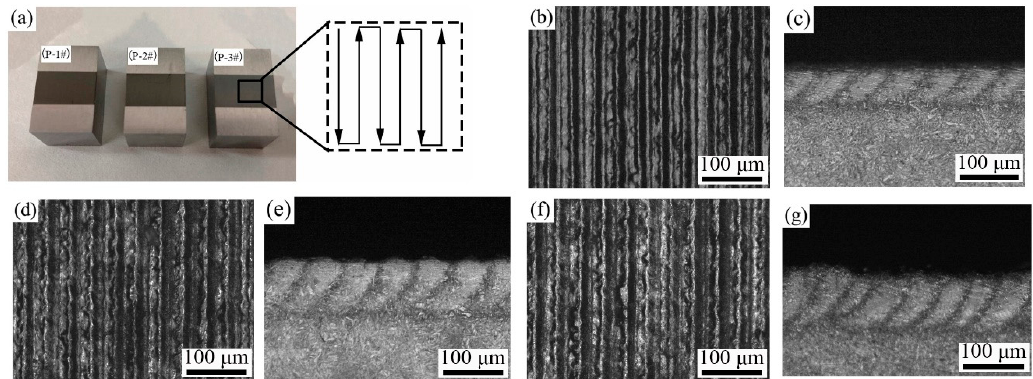
Figure 3. Morphology of bainitic steel after LSR. ( a ) Macroscopic overall morphology; ( b )–( c ), ( d )–( e ), and ( f )–( g ) are the surface and cross-section micro-morphology of P-1 #, P-2 #, P-3 #, respectively.